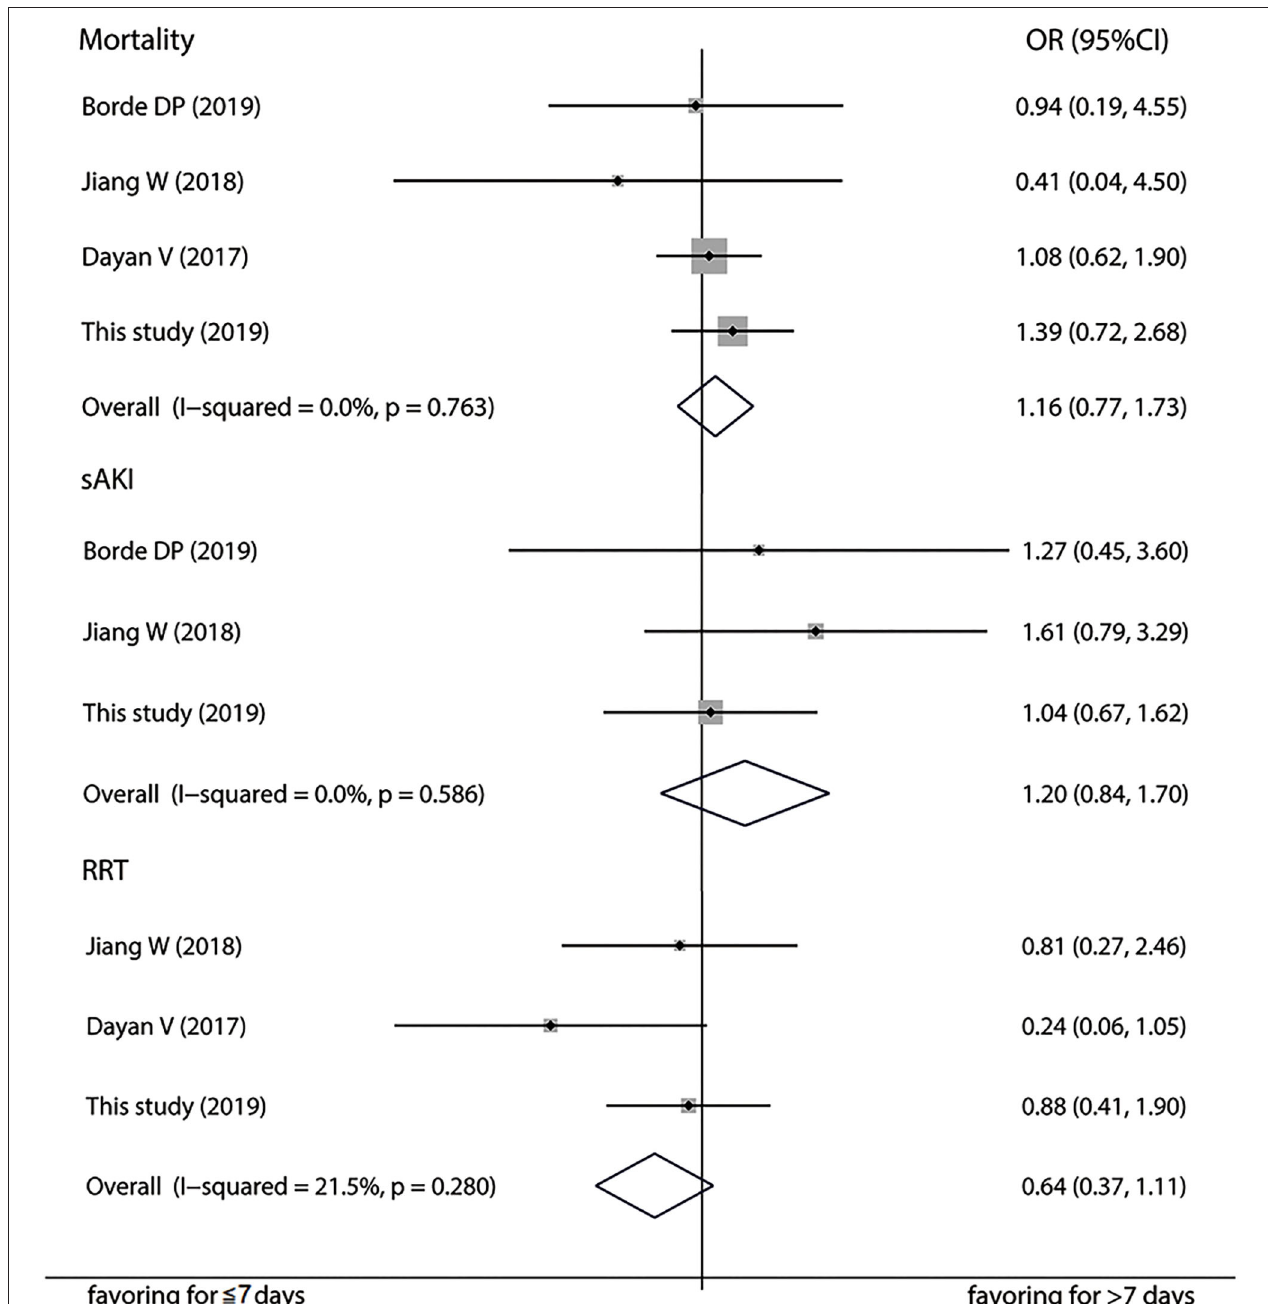
FIGURE 3 | Forest plot comparing ≤ 7-day and > 7-day intervals in terms of mortality, severe acute kidney injury, and renal replacement therapy in the